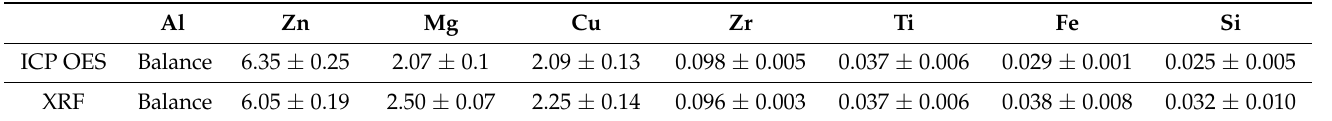
Table 1. Chemical composition of the DC-cast Zr-containing Al-Zn-Mg-Cu alloy (wt.%).